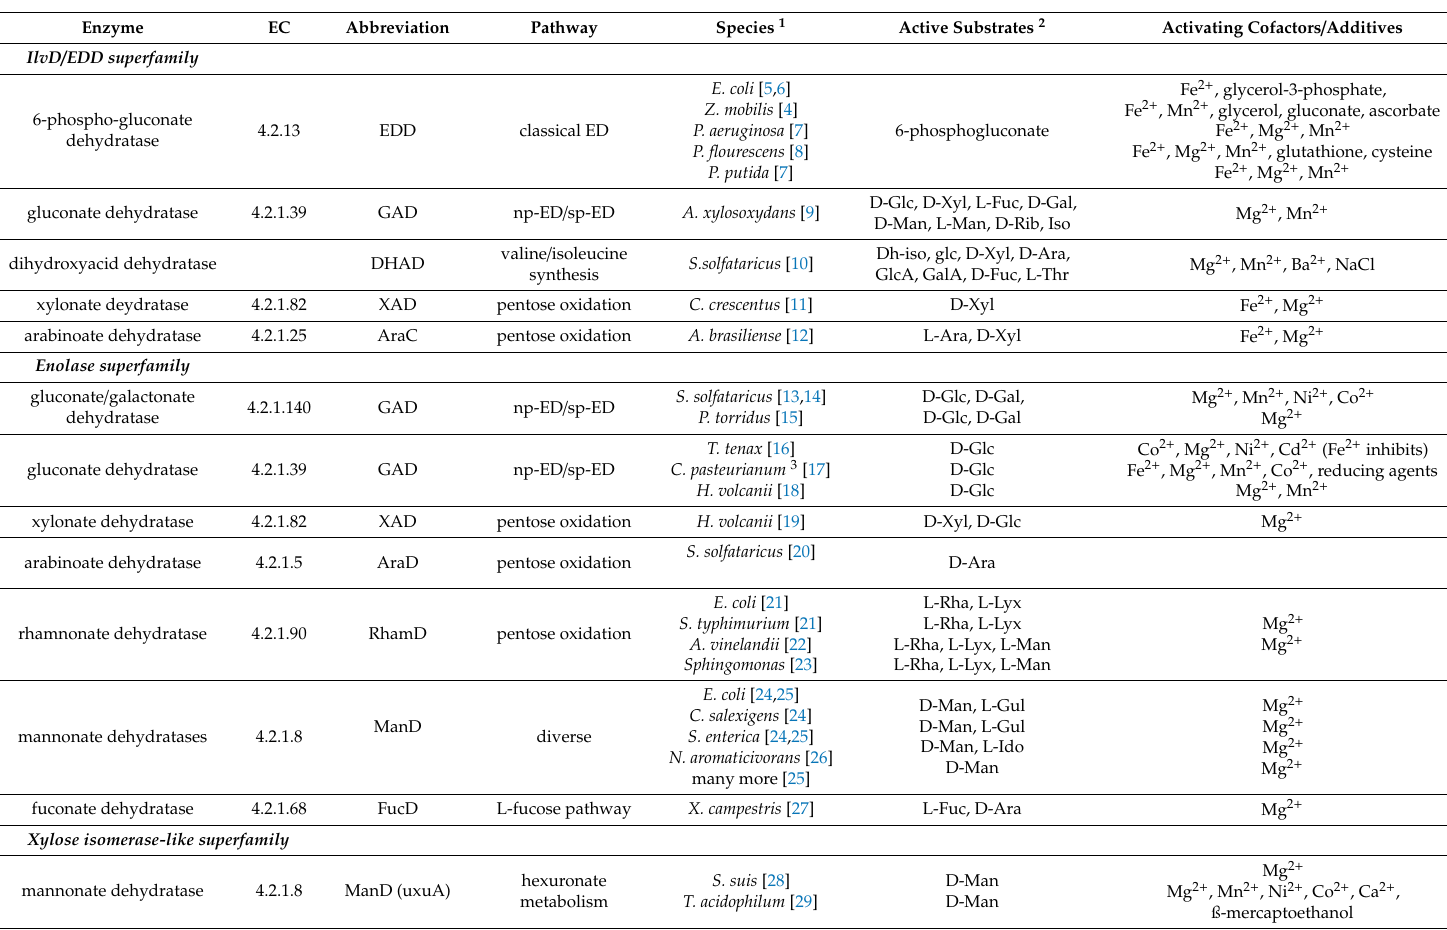
Table 1. Overview of dehydratases from IlvD / EDD, enolase and xylose isomerase-like superfamilies. D-Glc: D-gluconate, D-Xyl: xylonate, L-Fuc: fuconate, D-Gal: galactonate, D-Man: D-mannonate, L-Man: L-mannonate, D-Rib: D-ribonate, Iso: DL-isovalerate, Dh-iso: 2,3-dihydroxyisovalerate, D-Ara: D-arabinonate, GlcA: glucuronate, GalA: galacturonate, L-Thr: L-threonate, L-Ara: L-arabinonate, L-Rha: L-rhamnonate, L-Lyx: L-lyxonate, L-Gul: L-gulonate, L-Ido: